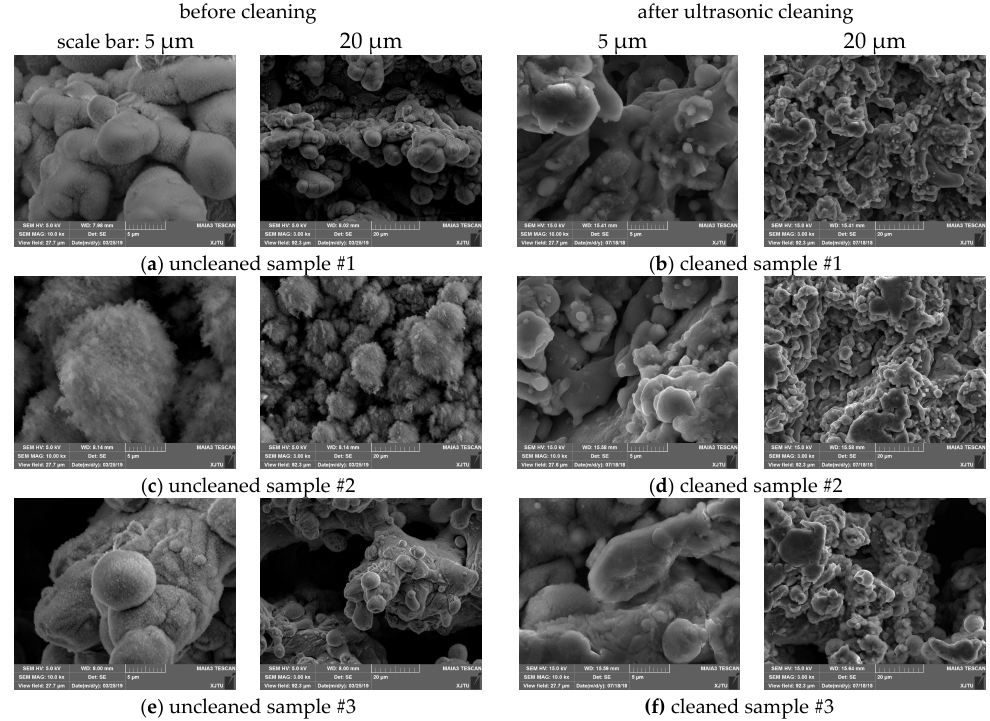
Figure 3. The surface SEM images of laser treated samples #1, #2, and #3. ( a ) Uncleaned laser- processed sample #1, ( b ) cleaned laser-processed sample #1, ( c ) uncleaned laser-processed sample #2, ( d ) cleaned laser-processed sample #2, ( e ) uncleaned laser-processed sample #3, and ( f ) cleaned laser-processed sample